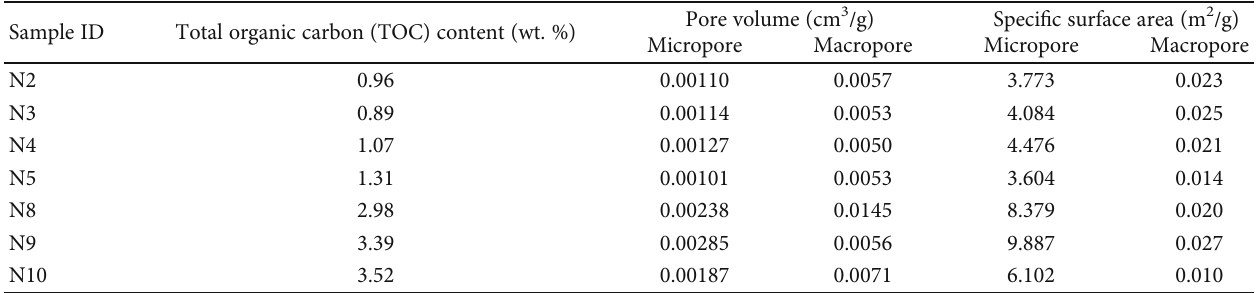
gas adsorption and mercury intrusion capillary pressure 2